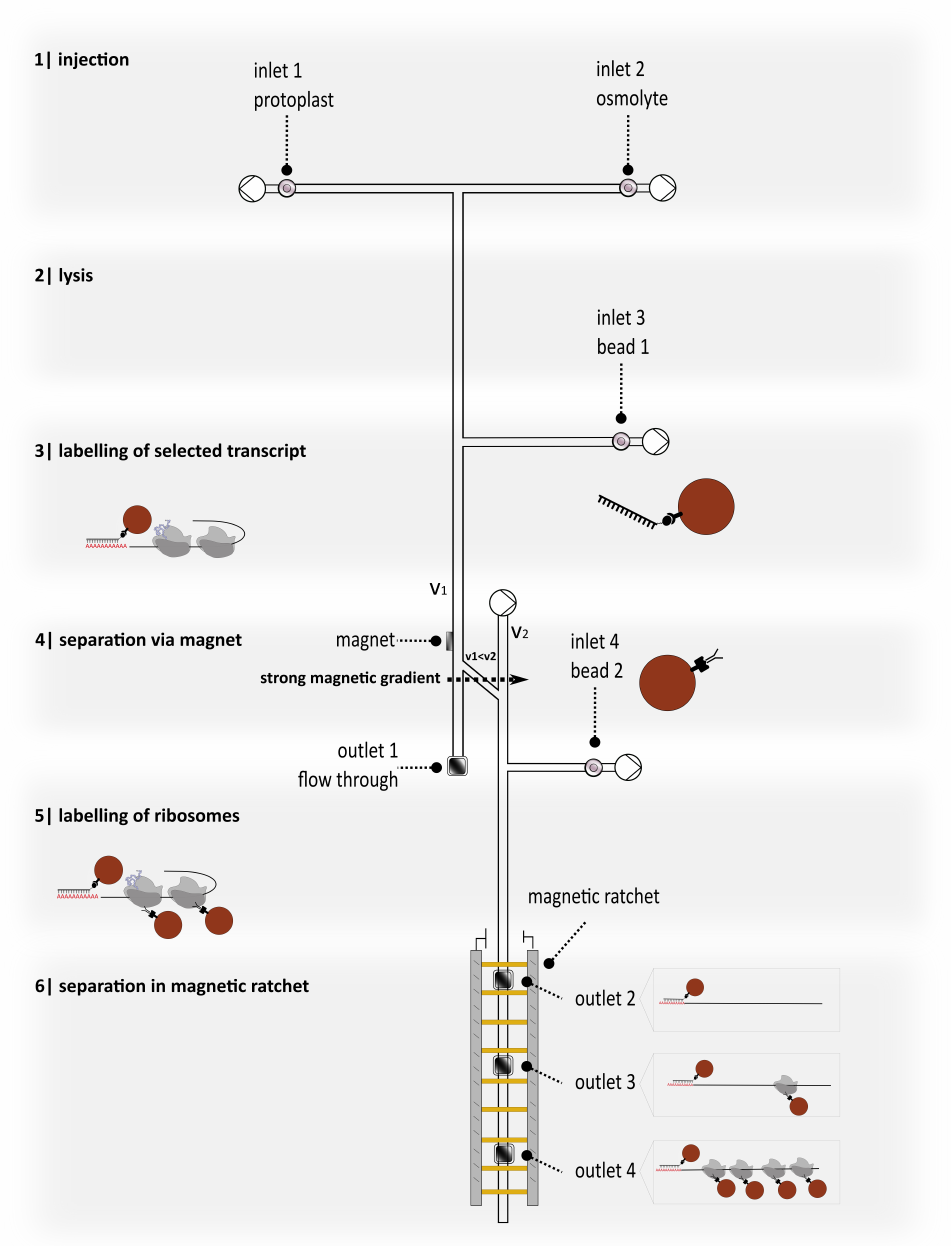
Figure 3. Schematics of microfluidic separation of di ff erentially labelled polysomes, including cell lysis, magnetic labelling, mixing, separation, and